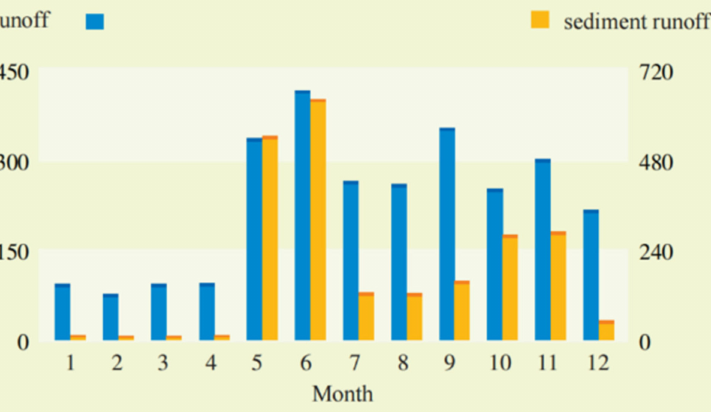
Figure 4. Time series of monthly runoff (unit: billion cubic meters) (blue) and sediment runoff (unit: ten thousand tons) (orange) at Gaoyao hydrological station during the 2015